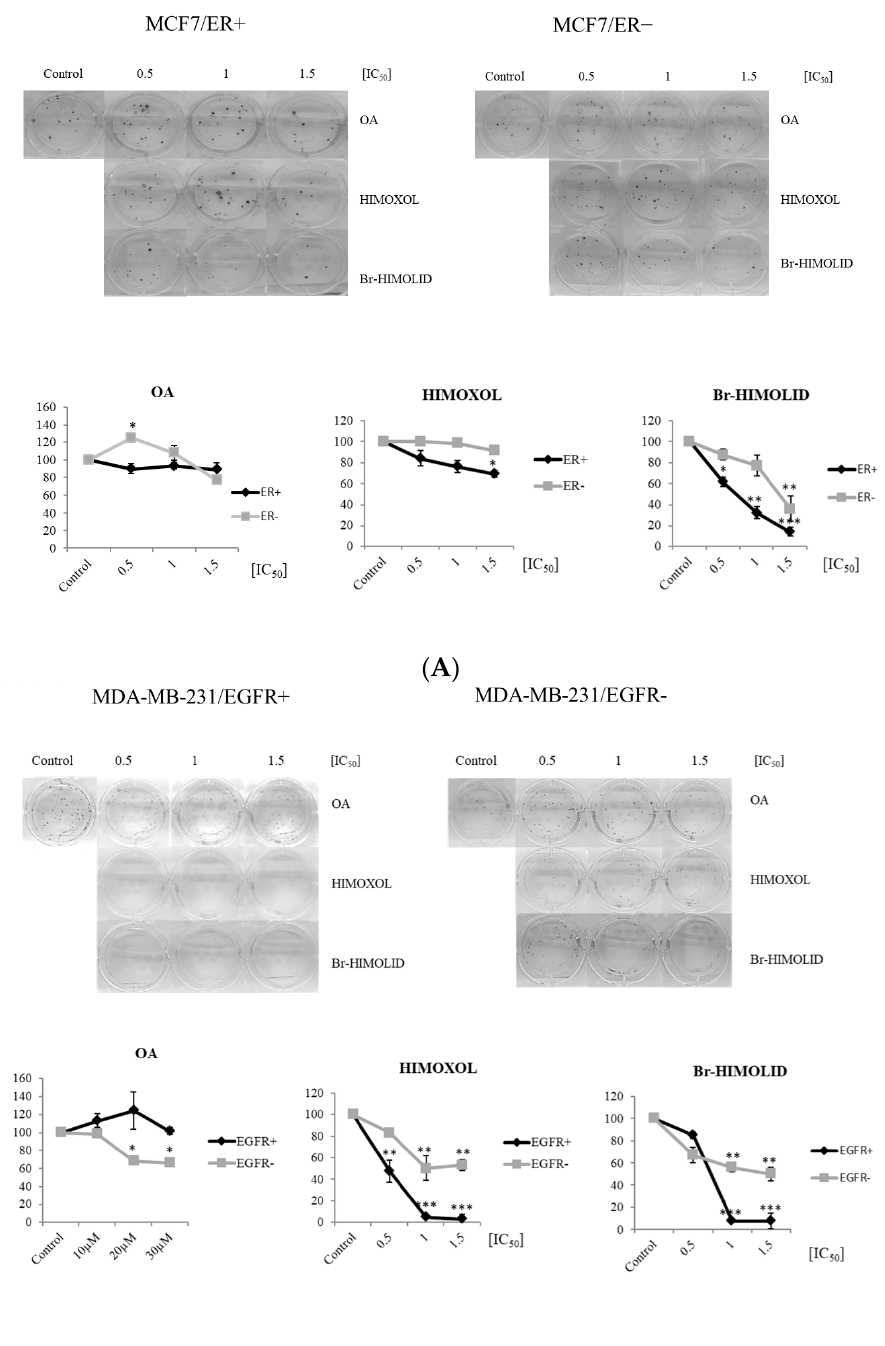
Figure 3. Influence of OA and its derivatives on colony formation potential of breast cancer cells. Breast cancer cells MCF7/ER+ and MCF7/ER − ( A ) as well as MDA-MB-231/EGFR+ and MDA-MB-231/EGFR − cells ( B ) were treated with different concentrations of studied compounds, i.e., OA, HIMOXOL, or Br-HIMOLID, in concentration range corresponding to 0.5, 1, and 1.5 × IC 50 . All experiments were performed in duplicates ± SD. * p< 0.05; ** p < 0.005; *** p < 0.001 2.4. Contribution of ER and EGFR to the Cell Cycle Distribution in MCF7/ER+/ − and MDA-